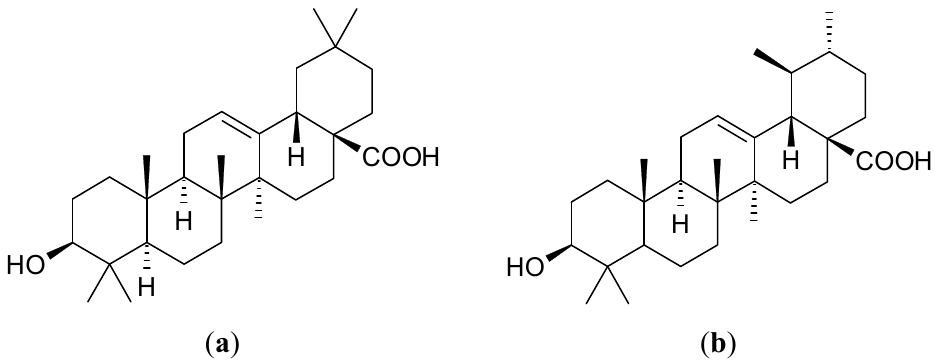
Figure 1. The chemical structures of: ( a ) oleanolic acid; ( b ) ursolic